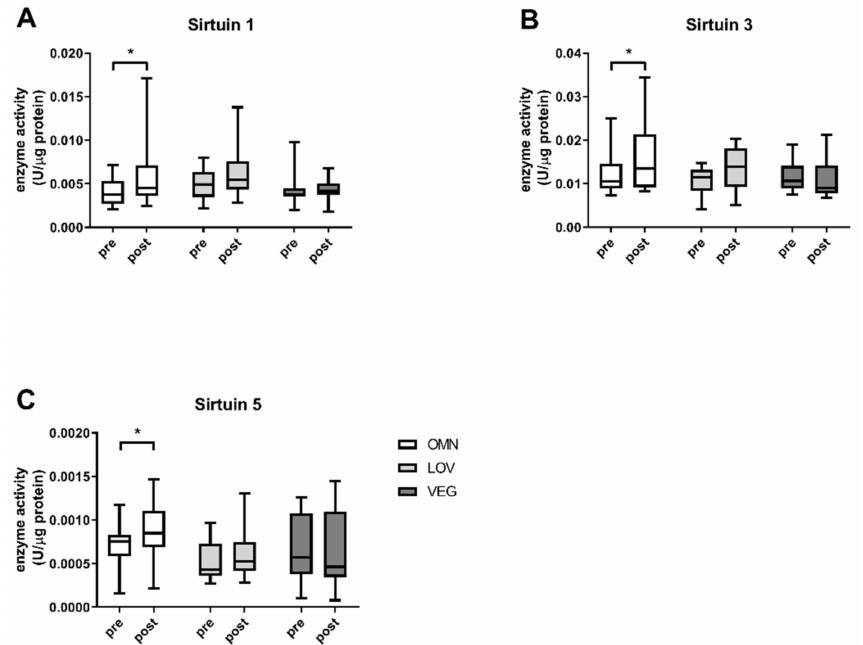
Figure 1. Absolute enzyme capacities (under substrate saturation) of sirtuins SIRT1, SIRT3, and